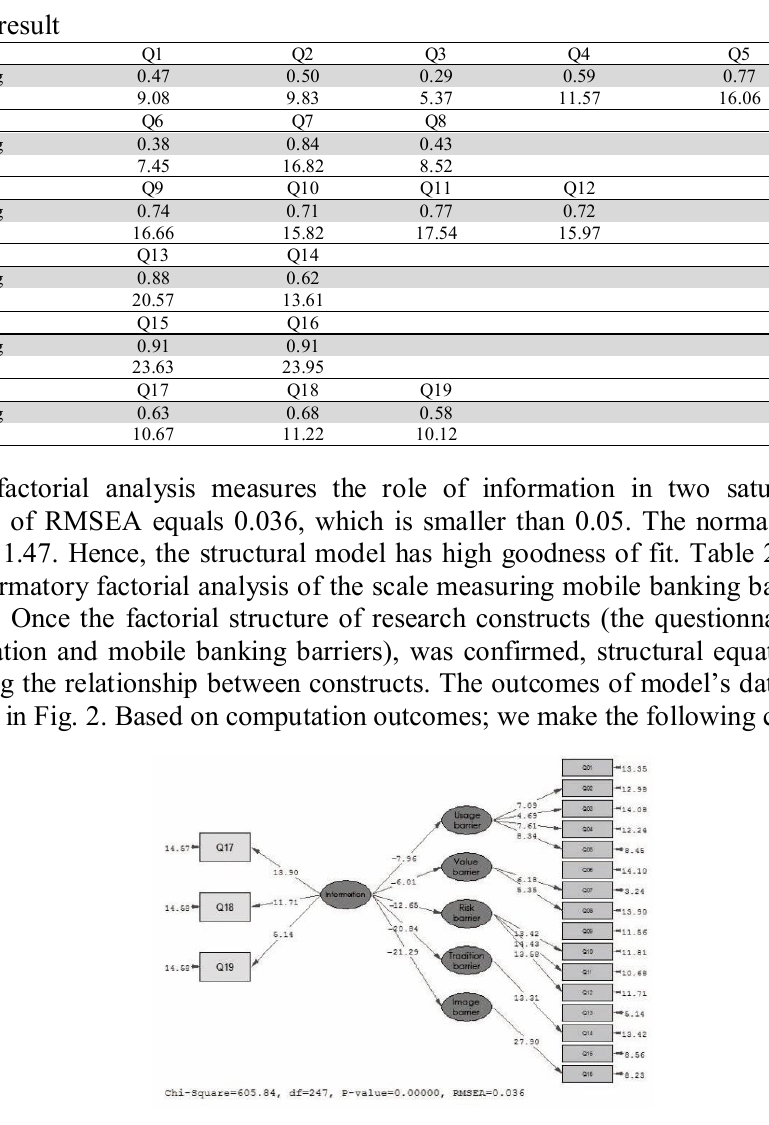
Fig. 2. The results of t-values of the estimated path